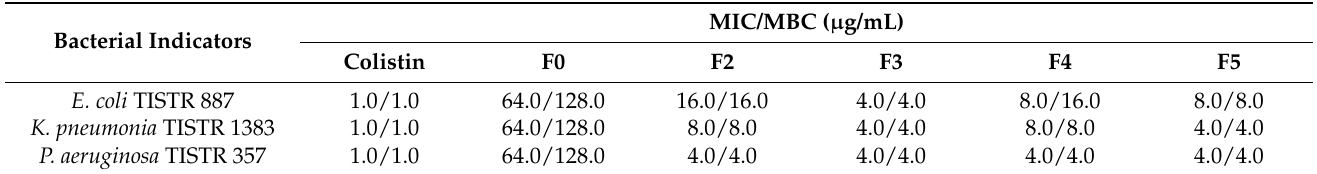
Table 2. Determination of MIC and MBC value. MIC and MBC of colistin, AgNPs in F0, and Col-AgNPs in F2–F5 against E. coli TISTR 887, K. pneumonia TISTR 1383, and P. aeruginosa TISTR 357.